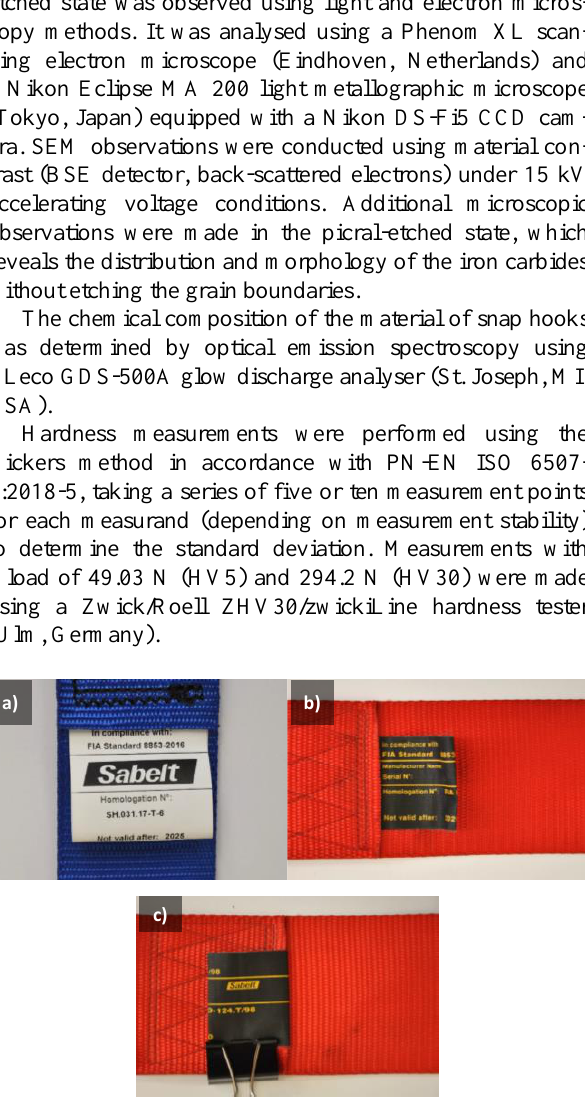
Fig. 1. Manufacturers' labels sewn onto the six-point harnesses containing information regarding compliance with the FIA standard and temporary homologation: a) original belt; b) c) imitations of the original belt